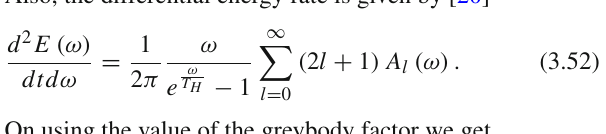
Also, the differential energy rate is given by